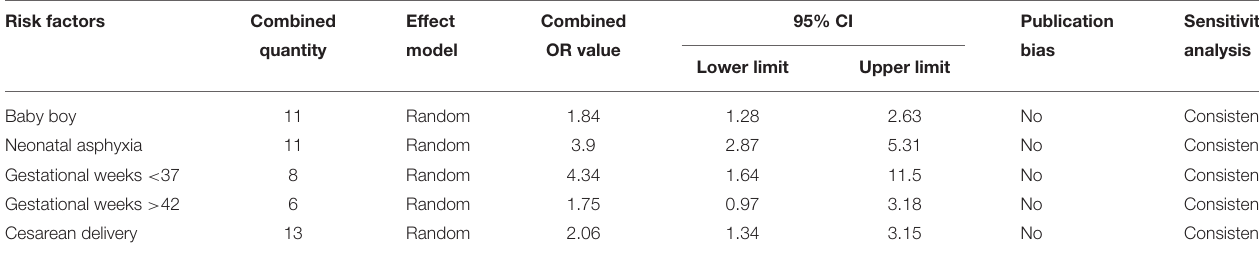
TABLE 4 | Risk factors present in